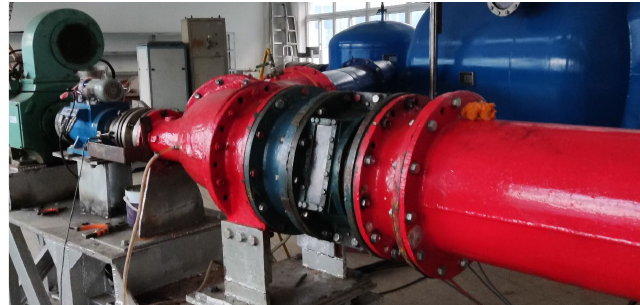
Figure 5. Physical diagram of the pump performance experiment. Table 2. Simulation component name.